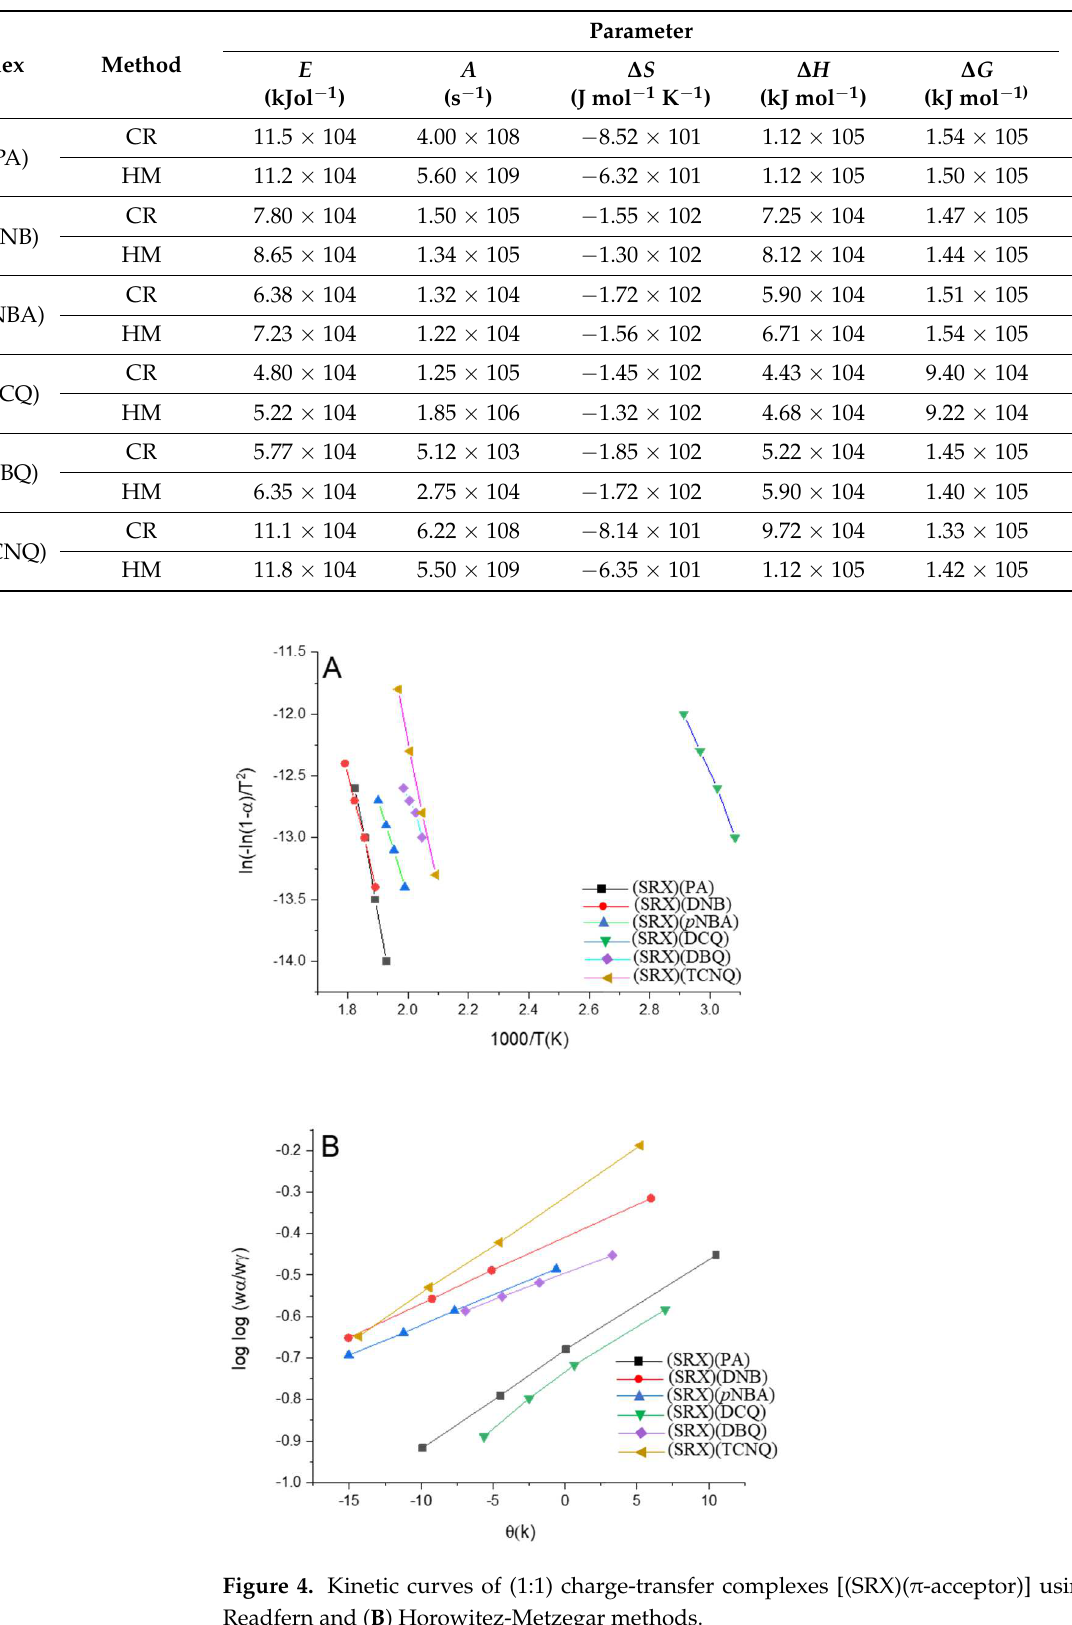
Table 1. Kinetic thermodynamic parameters for the six charge–transfer complexes based on Coats– Redfern (CR) and Horowitz–Metzger (HM) methods.